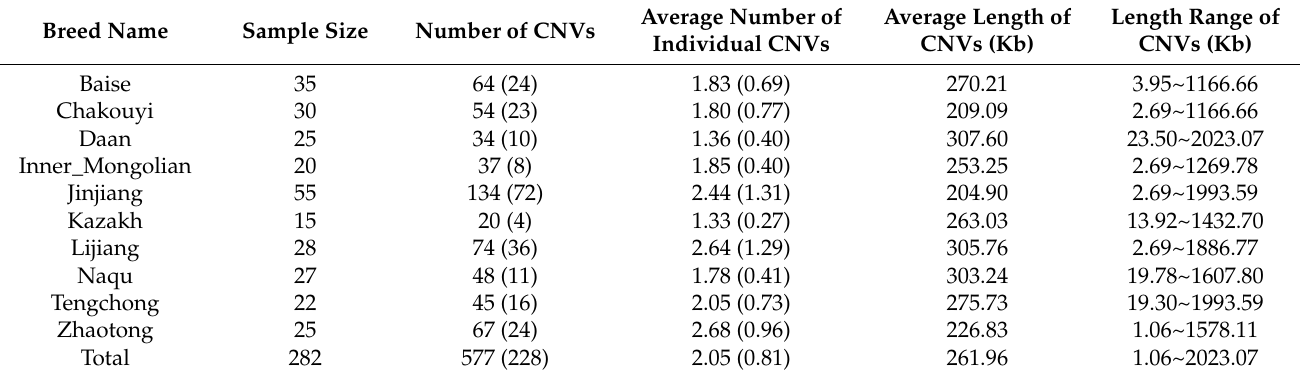
Table 2. Statistical results of CNV identification *.